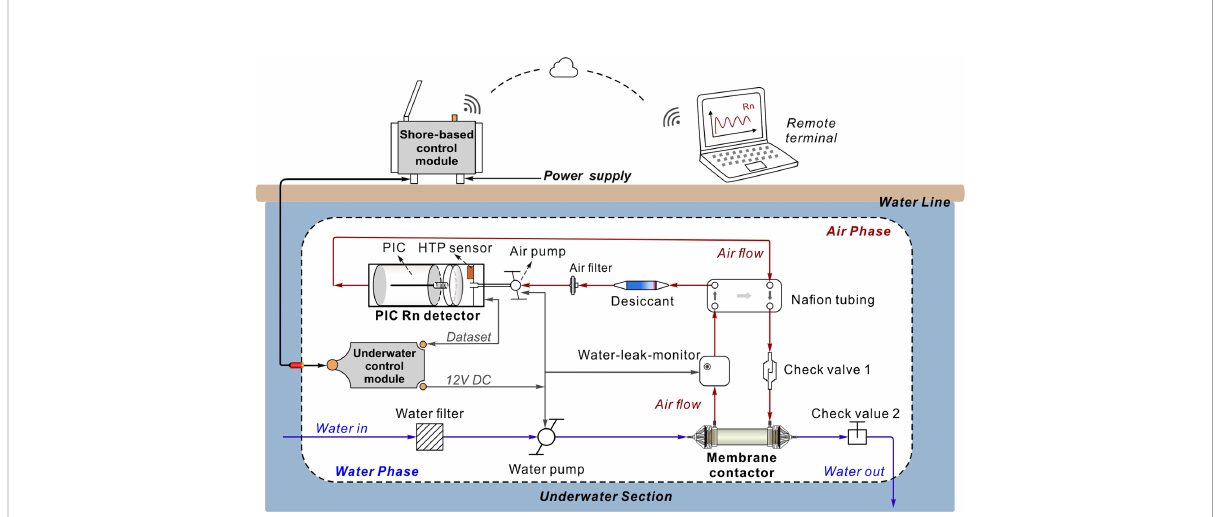
FIGURE 1 Schematic of the in-situ OUC-Rn measuring system. The components inside the dash lines are enclosed within a submersible capsule. Filtered water is continuously pumped to a membrane contactor where dissolved radon in water is equilibrated with radon-in-air in a closed air loop. Equilibrated air is directed into the active PIC radon detector after passing through a drying system of a Na fi on tubing and desiccant. Two check-valves and a water-leak-monitor prevent any unanticipated reverse fl ow. A THP sensor monitors the temperature, humidity and pressure within the PIC inner chamber. A shore-based control module provides power to the underwater system and stores real-time data and transmits this information via a data cloud to a remote terminal (i.e., cellphone or computer). The fi gure was hand-drawing utilizing CorelDRAW